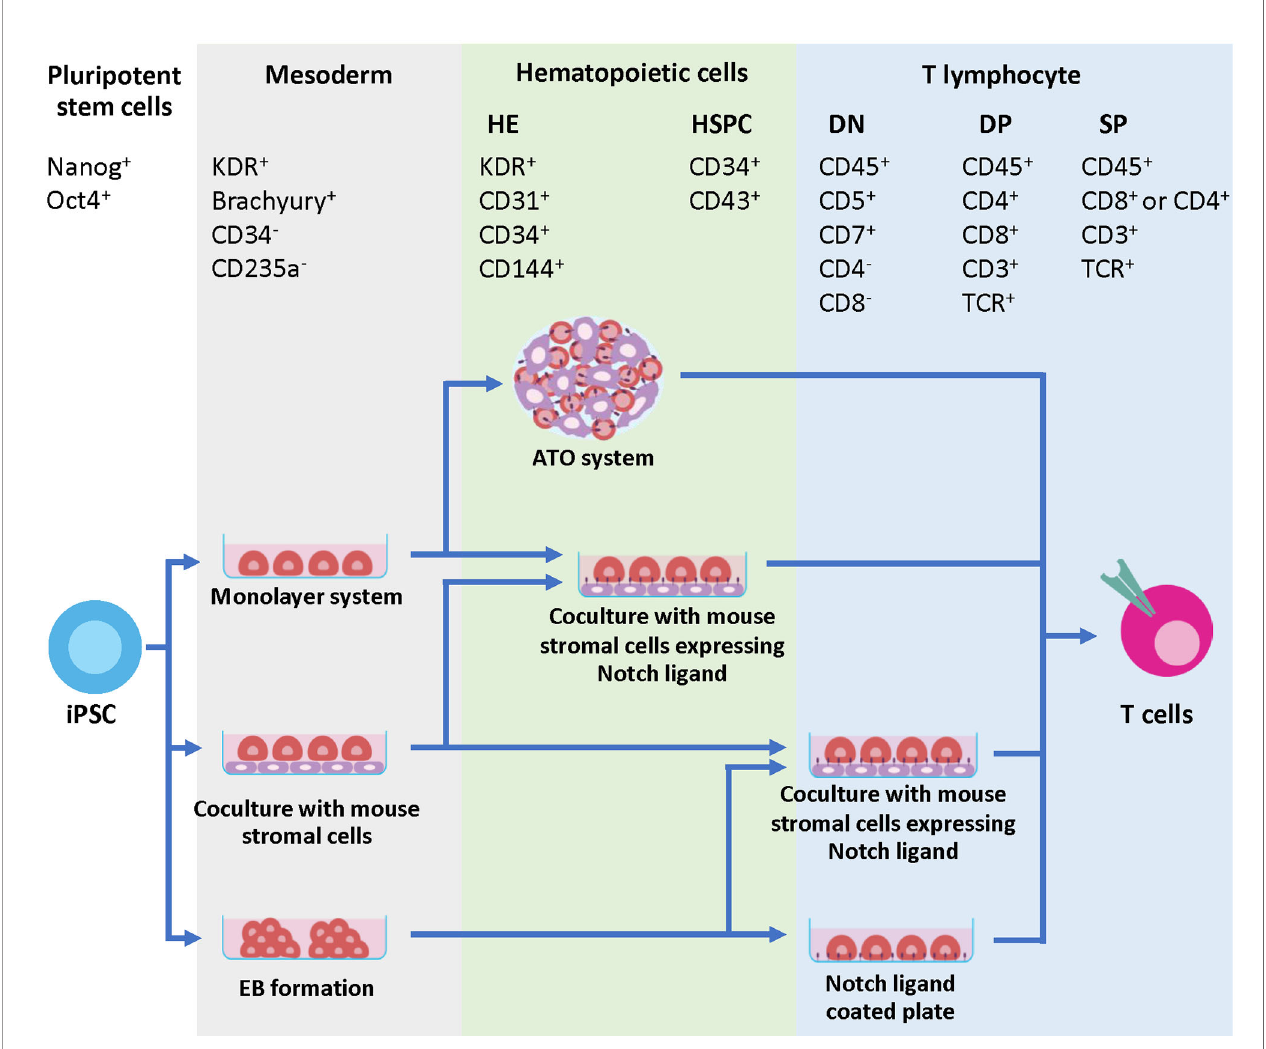
FIGURE 2 | Developmental markers during T cell differentiation and strategies to generate iPSC-derived T cells. The initial step of hematopoietic differentiation can be achieved by various protocols, including feeder-free protocols such as monolayer system, co-culture with mouse stromal cells and EB formation. During this step, the mesodermal (ME) cells expressing Brachyury and KDR are generated. The ME cells are committed further to HE, which express KDR, CD31, CD34 and CD144. During EHT process, CD43 + HSPC emerges from the HE layers. Speci fi cation of T cell lineage requires Notch signaling, which can be provided through co-culture with mouse stromal cells such as OP9-DL1 or OP9-DL4. Co-culture of iPSC-derived multipotent HSPCs with these cells in 2D or 3D system ef fi ciently generates mature T cells with phenotypes CD8 + CD4 - TCR + and CD3 + . Alternatively, the Notch signals can be provided through a coating matrix mixture of retronectin and recombinant DL4